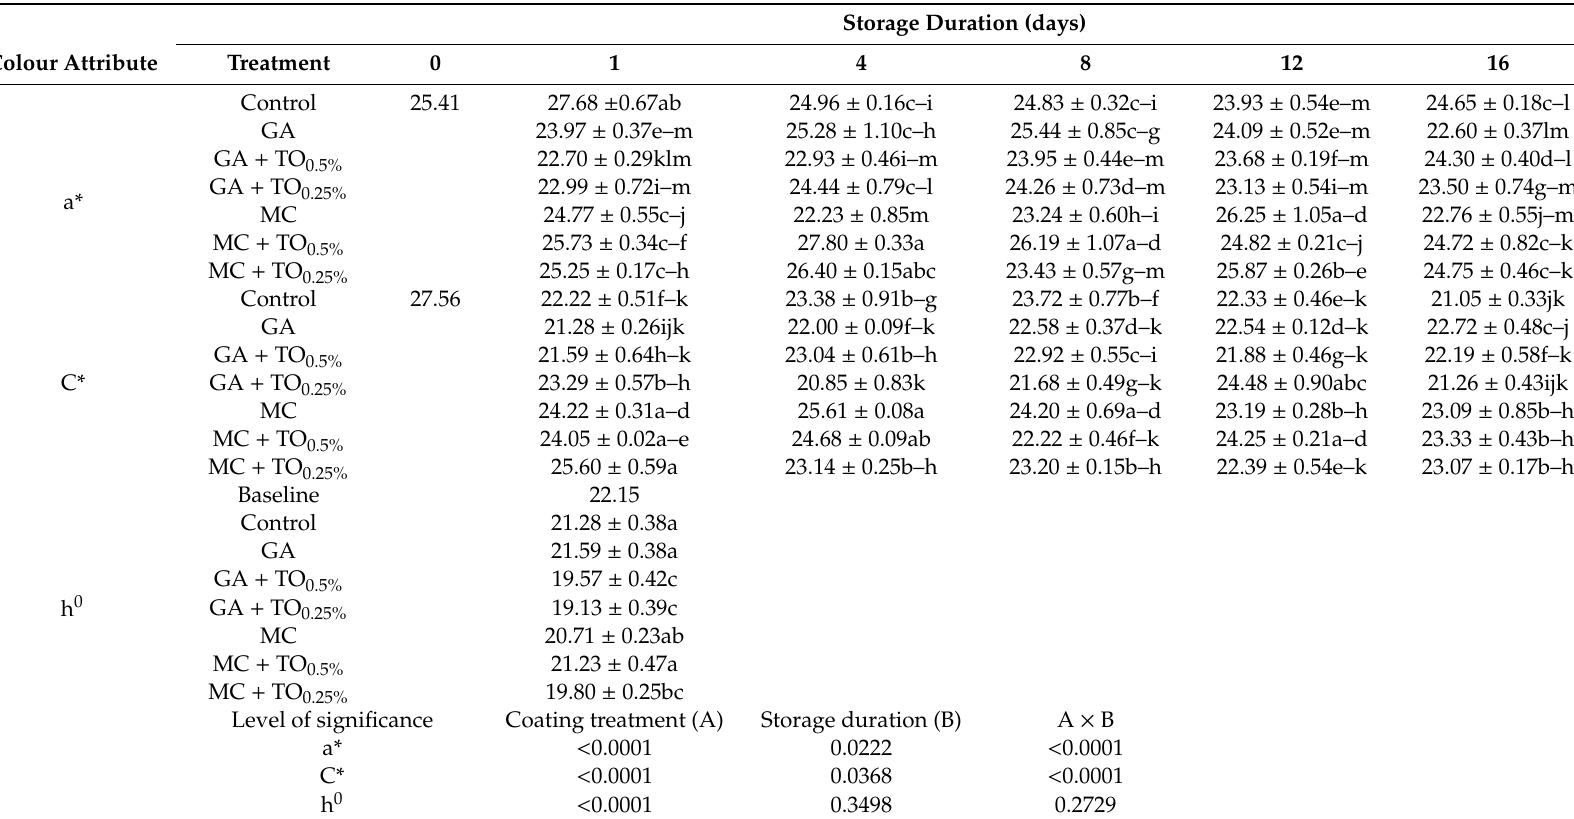
Table 1. E ff ects of gum arabic and methyl cellulose coatings enriched with thyme oil (0.5% and 0.25%) on colour attributes reported as redness (a*), chroma (C*)